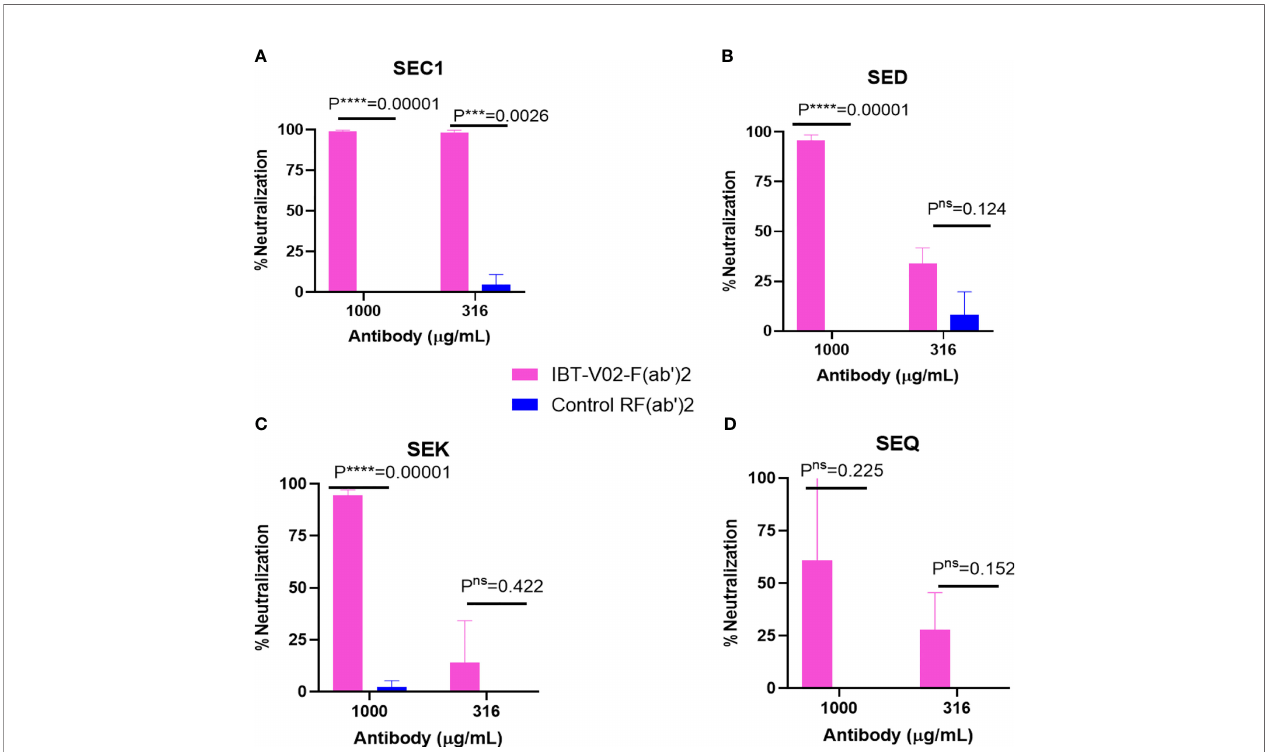
FIGURE 7 | Cross neutralization data against 90% effective concentration (EC 90 ) of (A) SEC1, (B) SED, (C) SEK, and (D) SEQ by IBT-V02-F(ab ’ )2 and control RF (ab ’ )2 tested in two different concentrations (1,000 and 316 µg/ml) of antibodies. The data were analyzed by unpaired multiple t-tests.p- values are represented as: ns, P > 0.05; ***, P ≤ 0.001; ****, P ≤ 0.0001.